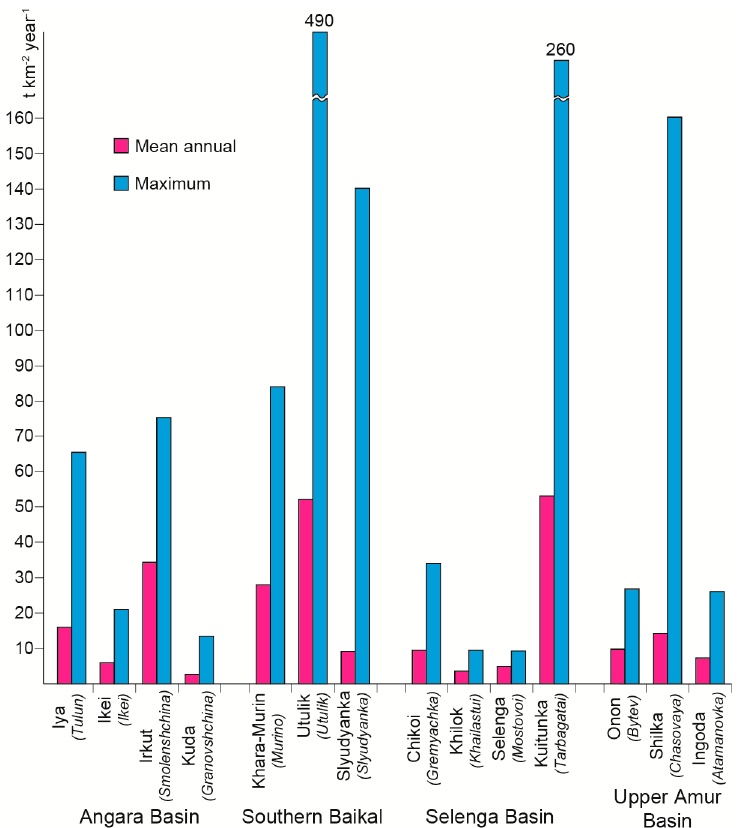
Figure 2. The ratio of the mean annual and maximum modulus of suspended sediment yield in the basins of Angara.